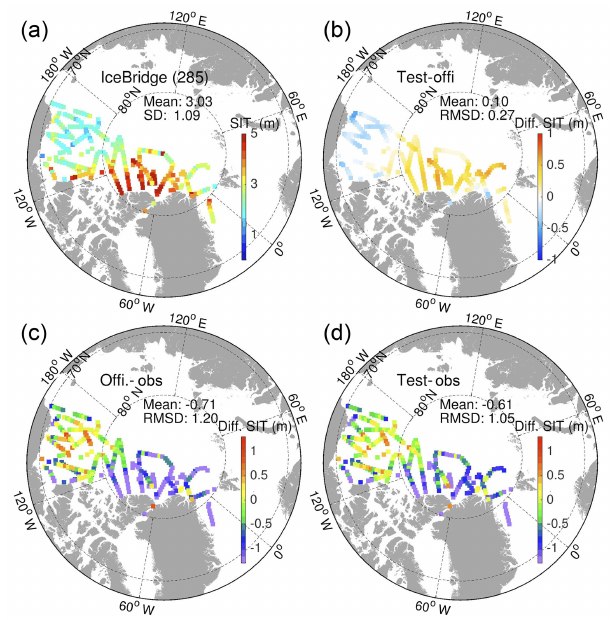
Figure 8. Scatterplots of SIT daily averaged of Official (blue) and Test (red) runs compared to IceBridge data. The dashed lines are the respective linear regression, the coefficient R 2 is the squared corre- lation to represent how strong of the linear relationship in Official or Test run. The black line is y = x